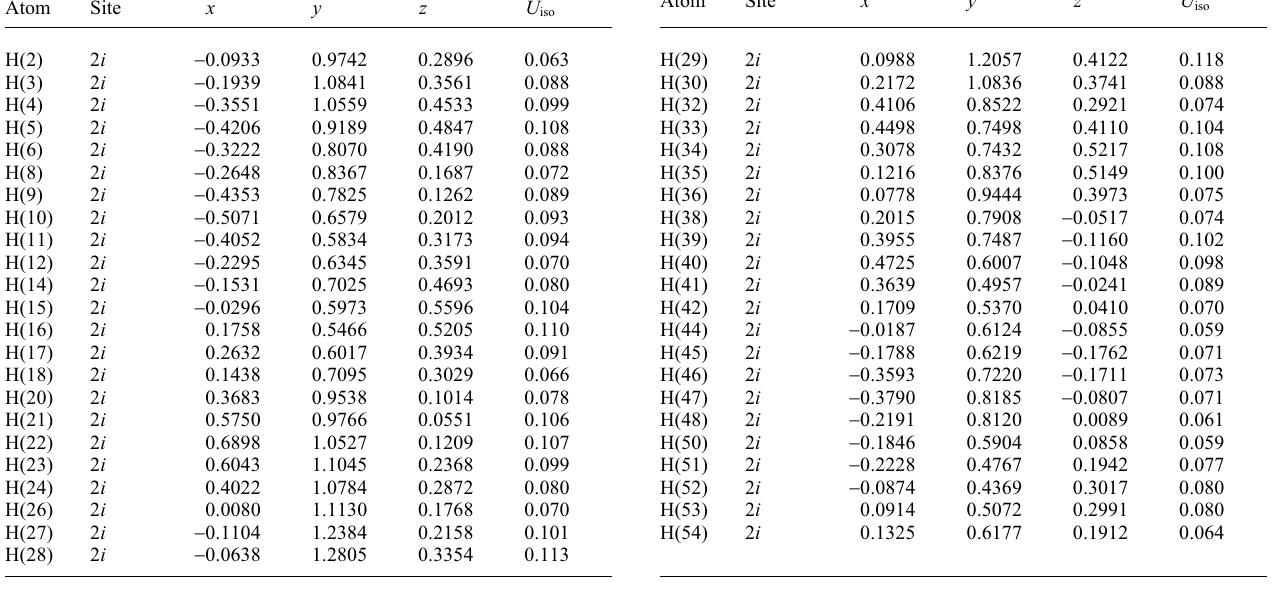
Table 3. Atomic coordinates and displacement parameters (in Å 2 ). Atom Site